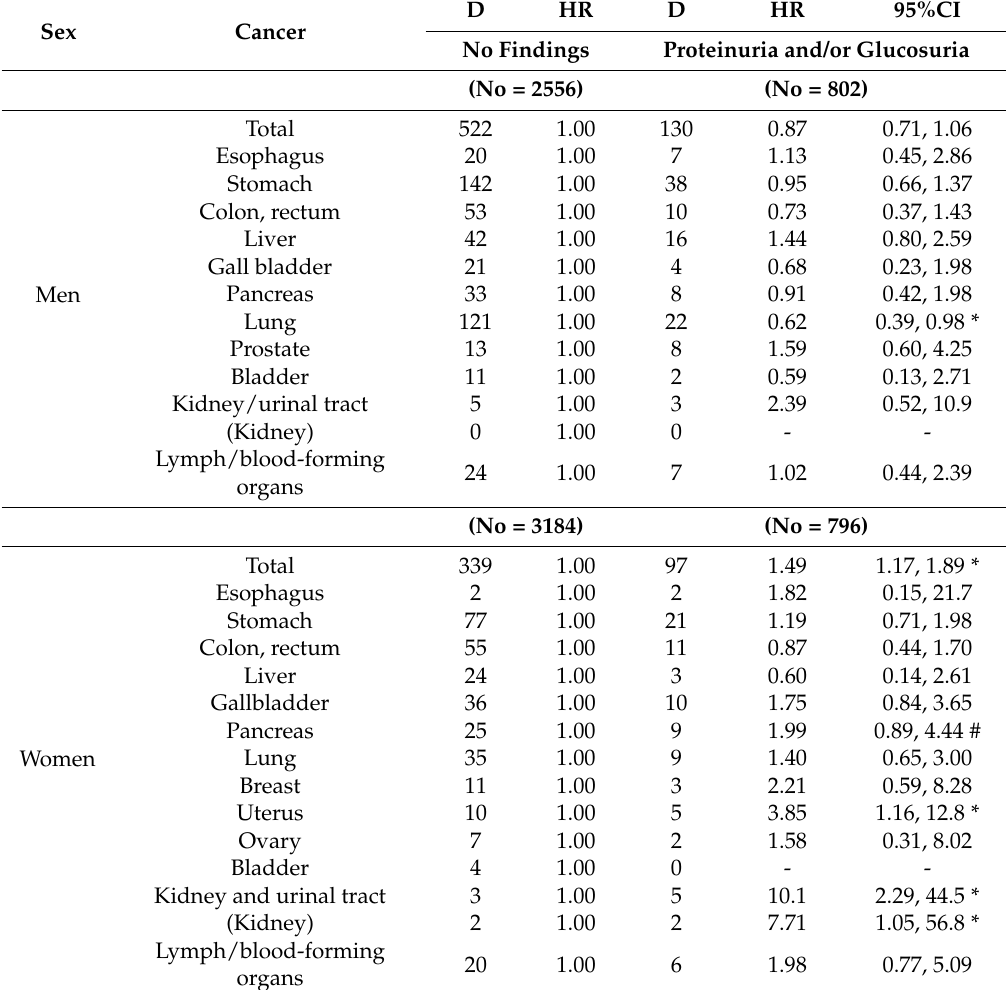
Table 7. Adjusted hazard ratios for cancer in subjects with proteinuria, glucosuria, and glucoproteinuria, compared with subjects without urinary findings living in the exposed